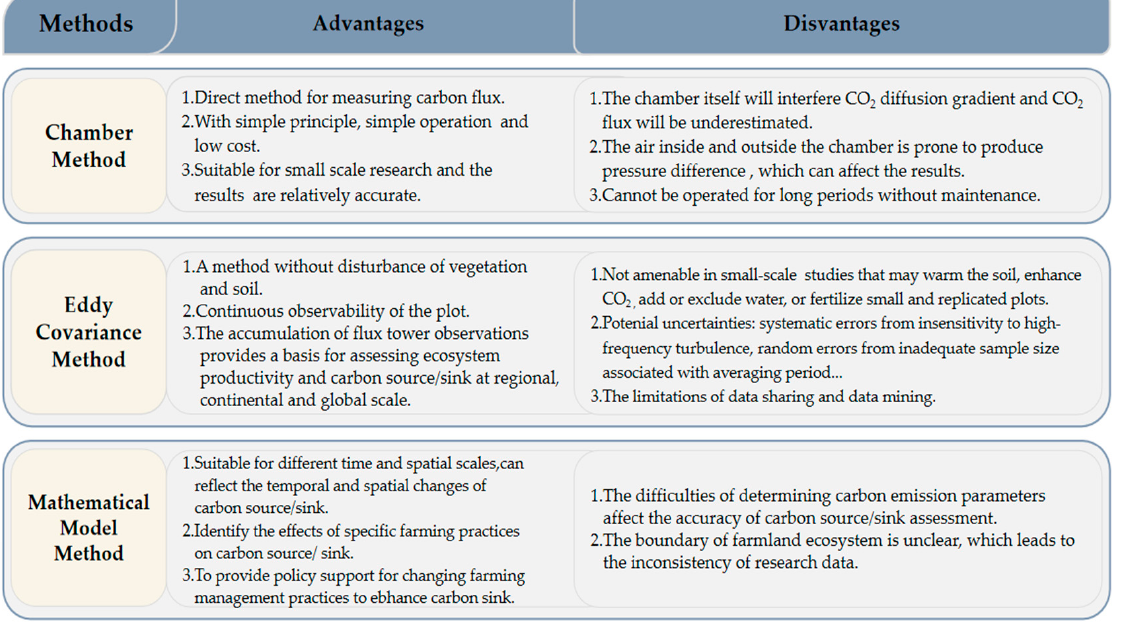
Figure 1. Advantages and disadvantages of research methods of carbon source and sink in arable land ecosystems.